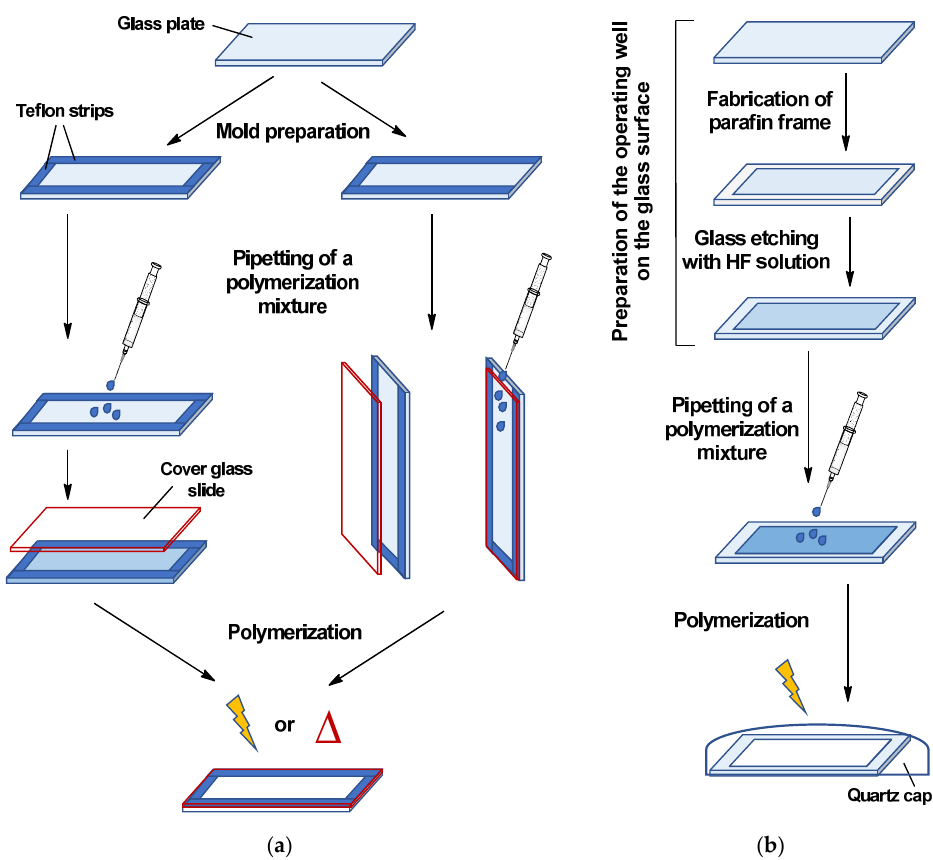
Figure 2. Schemes for the manufacture of polymer monolithic layers on the surface of the supporting glass plates: ( a ) Polymerization in a mold pre-formed from Teflon strips; ( b ) in situ polymerization in an operating well pre-formed by glass surface treatment. The covalent attachment of the polymer to the glass surface is achieved by the glass treatment with polymerizable silane agent (see Section 2.1 and Figure 1).